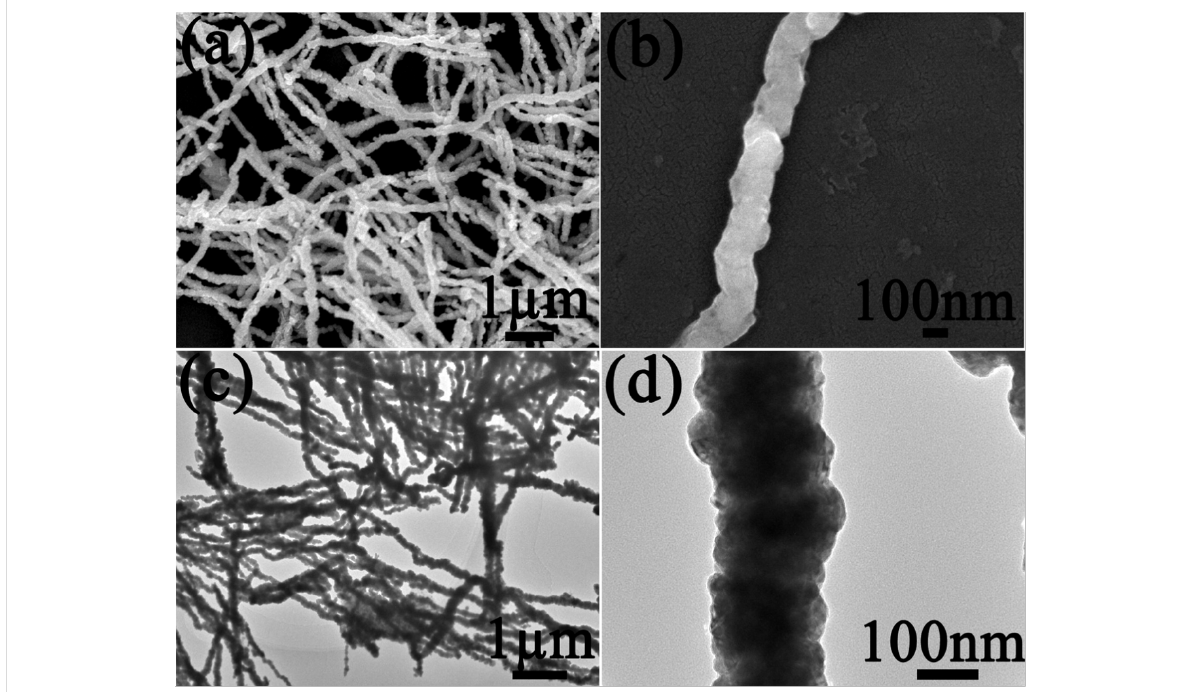
Figure 2: SEM (a) and magnified SEM (b) images as well as TEM (c) and magnified TEM (d) images of bimetallic Co–Cu nanowires at different magnifications.